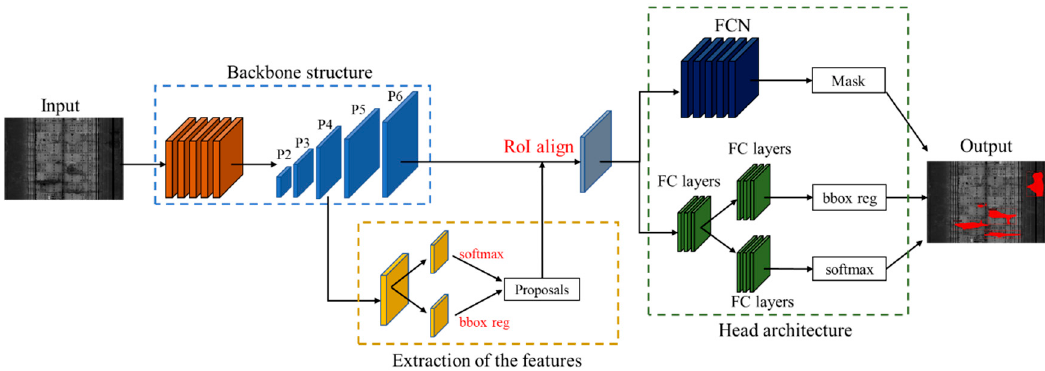
Figure 9. The overall structure of the mask and region-based convolutional neural network (Mask R-CNN) model.